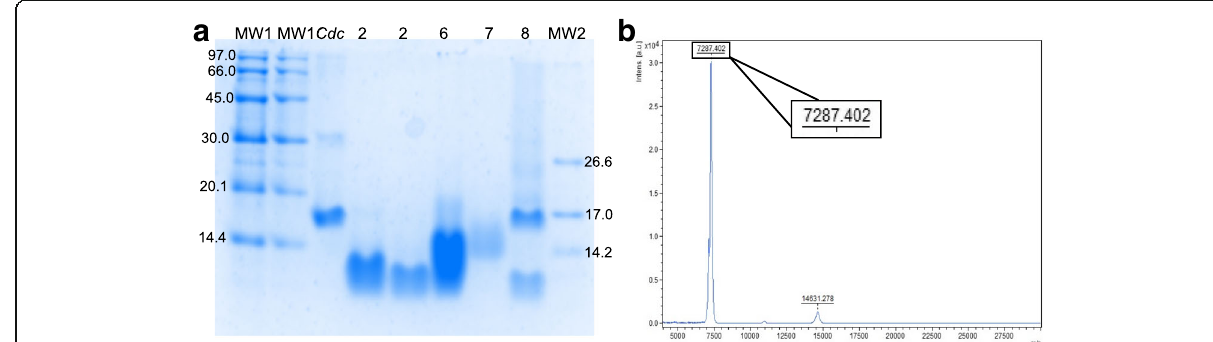
Fig. 2 Isolation profile of non-RGD disintegrin from C. d. collilineatus venom. a Tris-tricine-SDS-PAGE (16.5%), in non-reduced conditions and the gel was stained with 0.2% Coomassie Brilliant Blue G-250 . MW1 – molecular mass (97.0 – 14.4 kDa); Cdc – C. d. collilineatus venom; 2 – Fraction 2 from RP-FPLC first step; 6 – 8 – fractions 6, 7 and 8, respectively, from RP-FPLC second step; MW2 – molecular mass (26.6 – 1.06 kDa). b Mass spectrum of Fraction 6 eluted from RP-FPLC second step obtained by MALDI-TOF (positive linear mode) using α -cyano-4-hydroxycinnamic acid